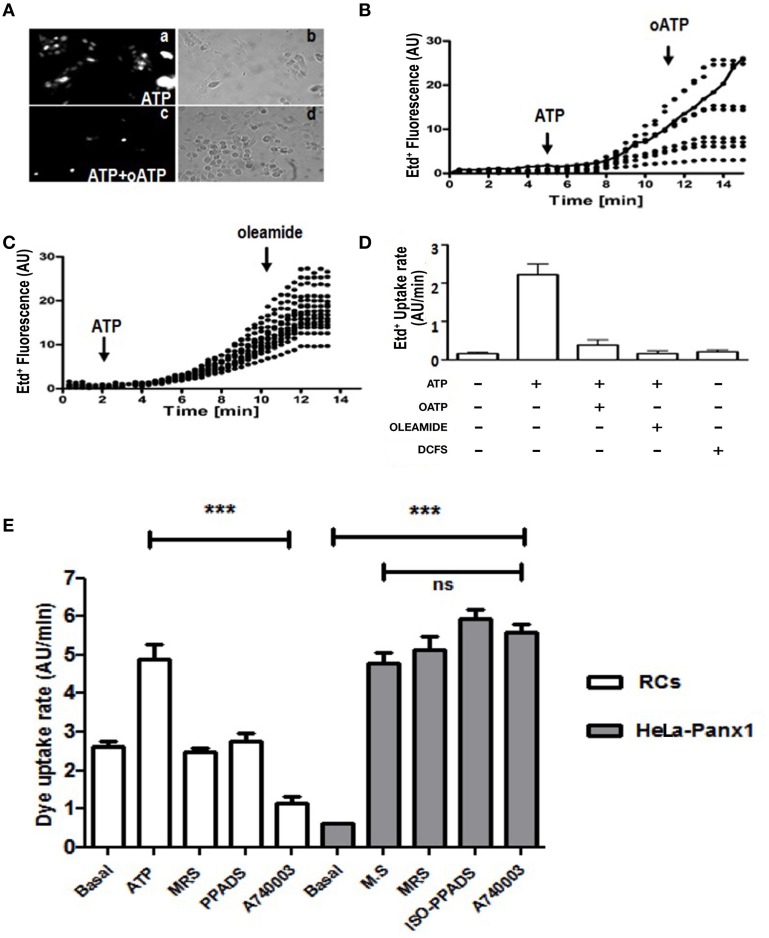
C2C12 RCs express functional P2X receptors and pannexin channels. C2C12 RCs seeded onto glass cover slips were maintained for 1 h in growth medium so they could attach. Then, cells were washed three times and after 0.5 h they were exposed to Krebs–Ringer saline solution containing 5 μM Ethidium (Etd+). Thereafter, cells were treated with 150 μM ATP and Etd+ uptake was evaluated. (Aa) Microphotograph taken 15 min after 150 μM ATP application. (Ac) co-application of 150 μM oATP blocked dye uptake induced by 150 μM ATP. (Ab, Ad) Phase contrast views of fields shown in Aa and Ac, respectively. (B) Time-lapse measurements of Etd+ uptake in several cells (8 in B and 14 in C) under control conditions (5 or 2 min, respectively) and after the application of 150 μM ATP (B, C), indicated with the arrow. After 10 or 8 min of recording under control conditions 150 μM oATP (B) or 100 μM oleamide (C) was applied (arrow). In (B), the continuous line represents the mean ± SEM of three experiments in cells treated only with ATP. (D) Bar graph showing the Etd+ uptake rate of cells treated as in (B) and (C). Each number corresponds to the average ± SEM (n = 3 experiments); 8–15 cells were recorded per experiment. In addition, cells were exposed to saline solution without Ca2+ and Mg2+ (DCFS), known to induce Cx HC opening. (E) Etd+ uptake rate in RCs treated with ATP or in HeLa-Panx1 cells treated with mechanical stress (M.S.) to induce opening of Panx1 channels. In both cell types the effect of blockade of P2Y1R (30 μM MRS2179), P2XRs (50 μM iso-PPADS) or P2X7R (10 μM A740003) on the Etd+ uptake rate was evaluated. ***p < 0.001.